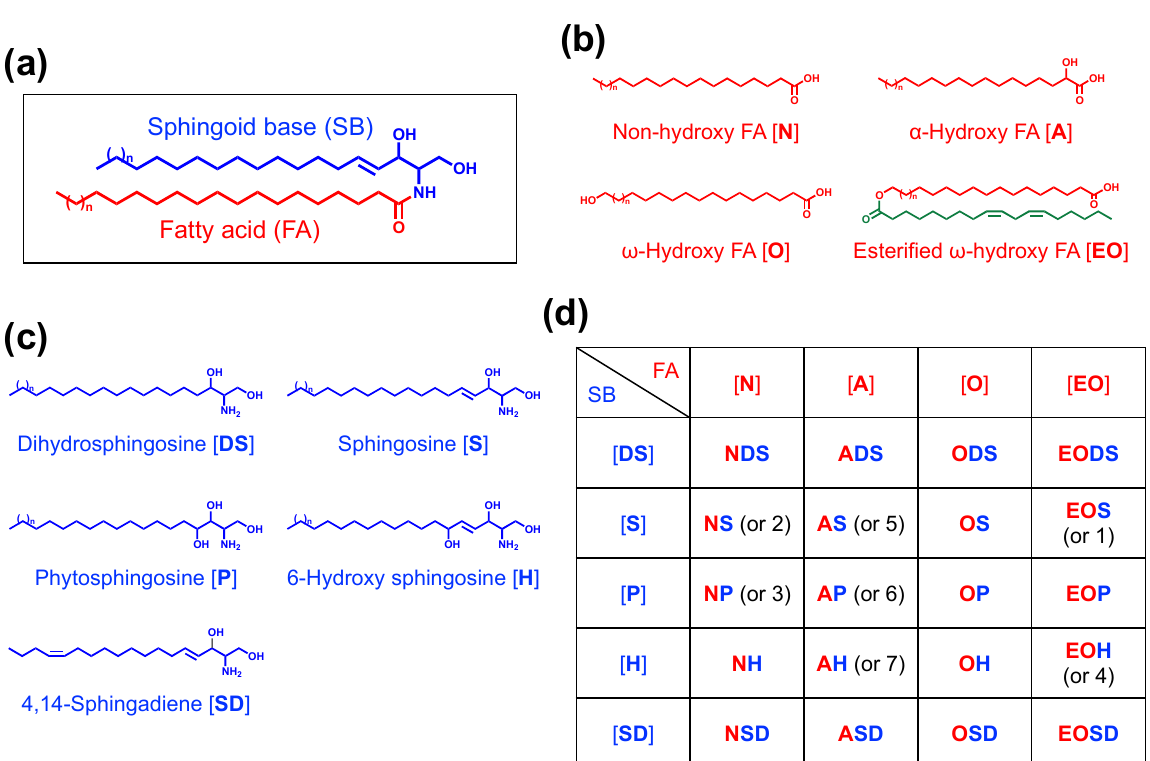
Figure 2. The structure and nomenclature of ceramides. ( a ) A ceramide is composed of a sphingoid base (SB) and a fatty acid (FA). ( b , c ) FAs ( b ) and SBs ( c ) in the major ceramide classes in human epidermis. ( d ) The different classes of ceramides are designated by a combination of the abbreviations of FAs and SBs. The numbers indicate their former numerical nomenclature.